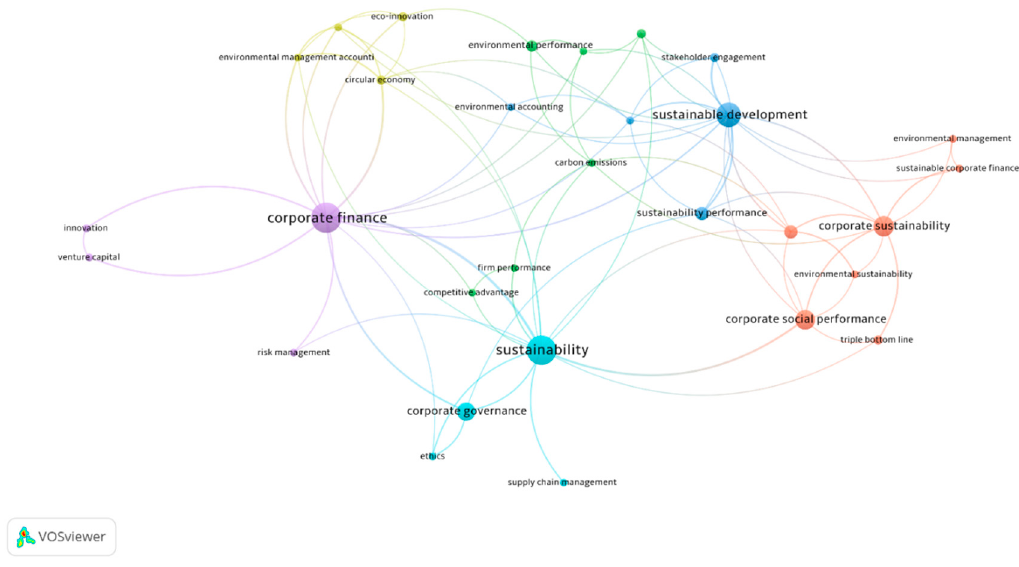
Figure 4. Co-occurrence of author keywords by clusters. Table 2. Co-occurrence of author keywords.